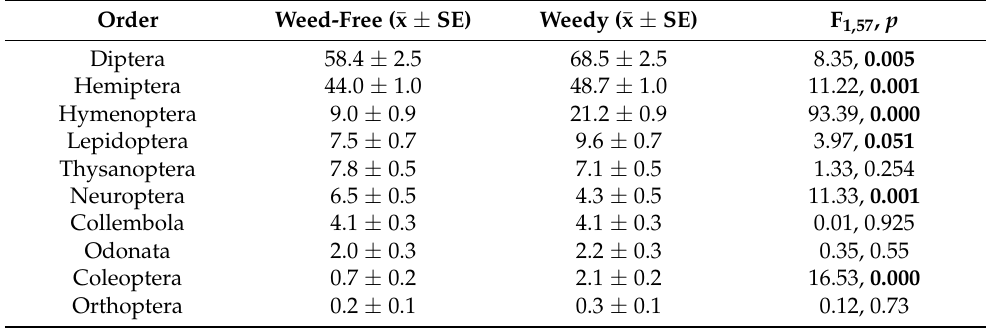
Table 2. Insect orders on mango, weedy vs. weed-free. Number of occurrences on each individual tree over the study duration, mean abundance and SE for each treatment, arranged by density ranking. Significant differences have p -values in bold, as shown by GLM MANOVA. N = 30 trees for each treatment. _ _ Order Weed-Free ( x ± SE) Weedy ( x ± SE) F 1,57 , p Diptera 58.4 ± 2.5 Hemiptera